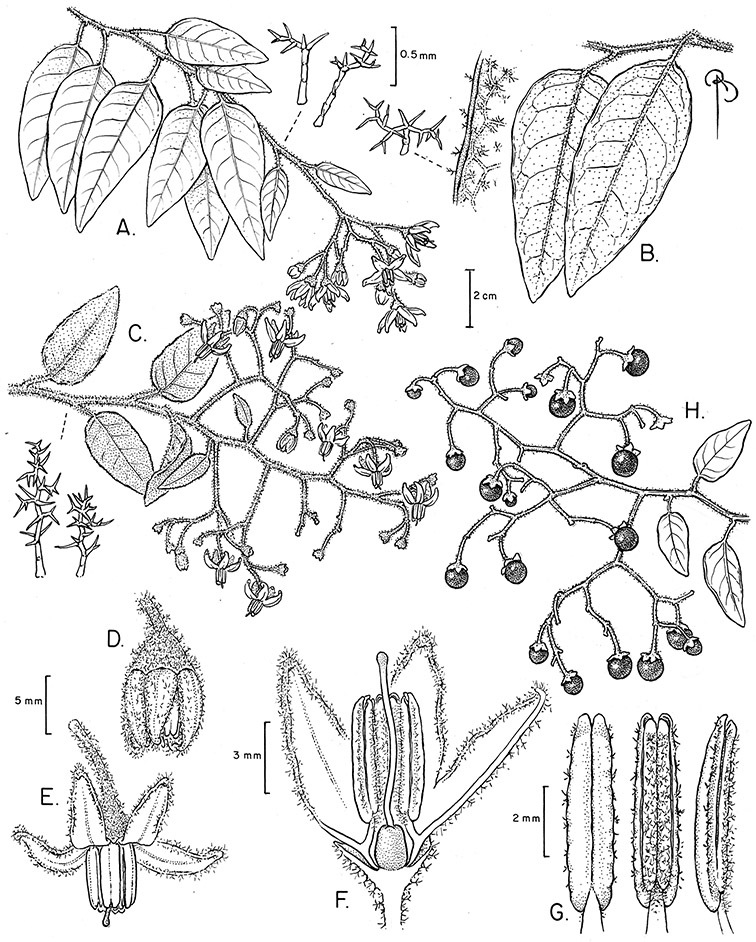
Solanum aureum Dunal. (A drawn from Juncosa 2335, NY B drawn from Zak 1845
C–G drawn from Rose 22963
H drawn from Cerón et al. 11842). Illustration by Bobbi Angell.